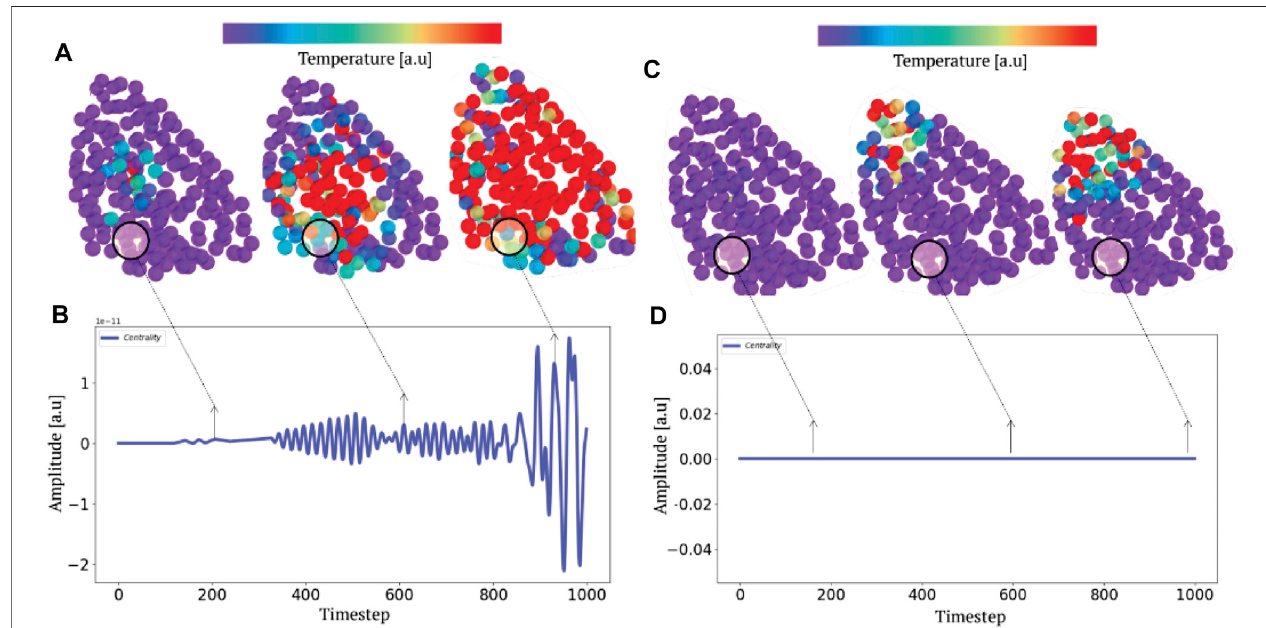
FIGURE8| Selectiveparametricexcitationandanisotropicheattransport.Aparametricexcitationatthehighestfrequency (A) and (C) producesanon-equilibrium transportphenomenon.Trackingtheprogression (B,D) ofheat fi eldsbymoleculardynamicsdependingonwhetherthesystemisexcitedinaregionofhigh (A) orlow (B) potential (or connectivity) localization illustrates the anisotropic nature of the thermal